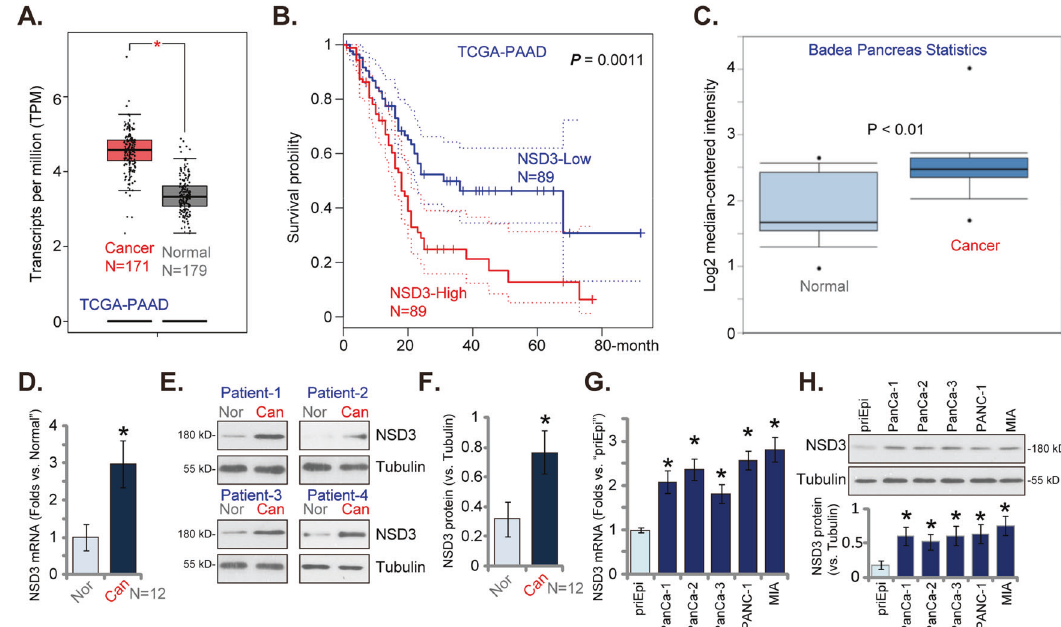
Fig. 1 NSD3 is overexpressed in pancreatic cancer tissues and cells. TCGA-PAAD cohorts show relative NSD3 mRNA expression in 171 cases of pancreatic ductal adenocarcinoma (PDAC) tissues ( “ Cancer ” ) and 179 cases of normal pancreatic tissues ( “ Normal ” ) ( A ). Kaplan-Meier survival analyses of NSD3 -low ( N = 89) and NSD3 -high ( N = 89) PDAC patients ( B ). Badea Pancreas Statistics shows relative NSD3 mRNA expression in PDAC cancer tissues ( “ Cancer ” ) and matched surrounding normal pancreatic tissues ( “ Normal ” ) ( C ). NSD3 mRNA and protein expressions in pancreatic cancer tissues ( “ Can ” ) and matched surrounding normal pancreatic tissues ( “ Nor ” ) from 12 ( N = 12) local PDAC patients were tested by qRT-PCR ( D ) and western blotting ( E , F ) assays. NSD3 mRNA ( G ) and protein ( H ) expressions in described pancreatic cancer cells and epithelial cells ( “ priEpi ” ) were tested. Data were presented as mean ± standard deviation (SD). * P < 0.05 vs. “ Normal ” tissues ( A – C ). * P < 0.05 vs. “ Nor ” tissues ( D , F ). * P < 0.05 vs. “ priEpi ” cells ( G and H